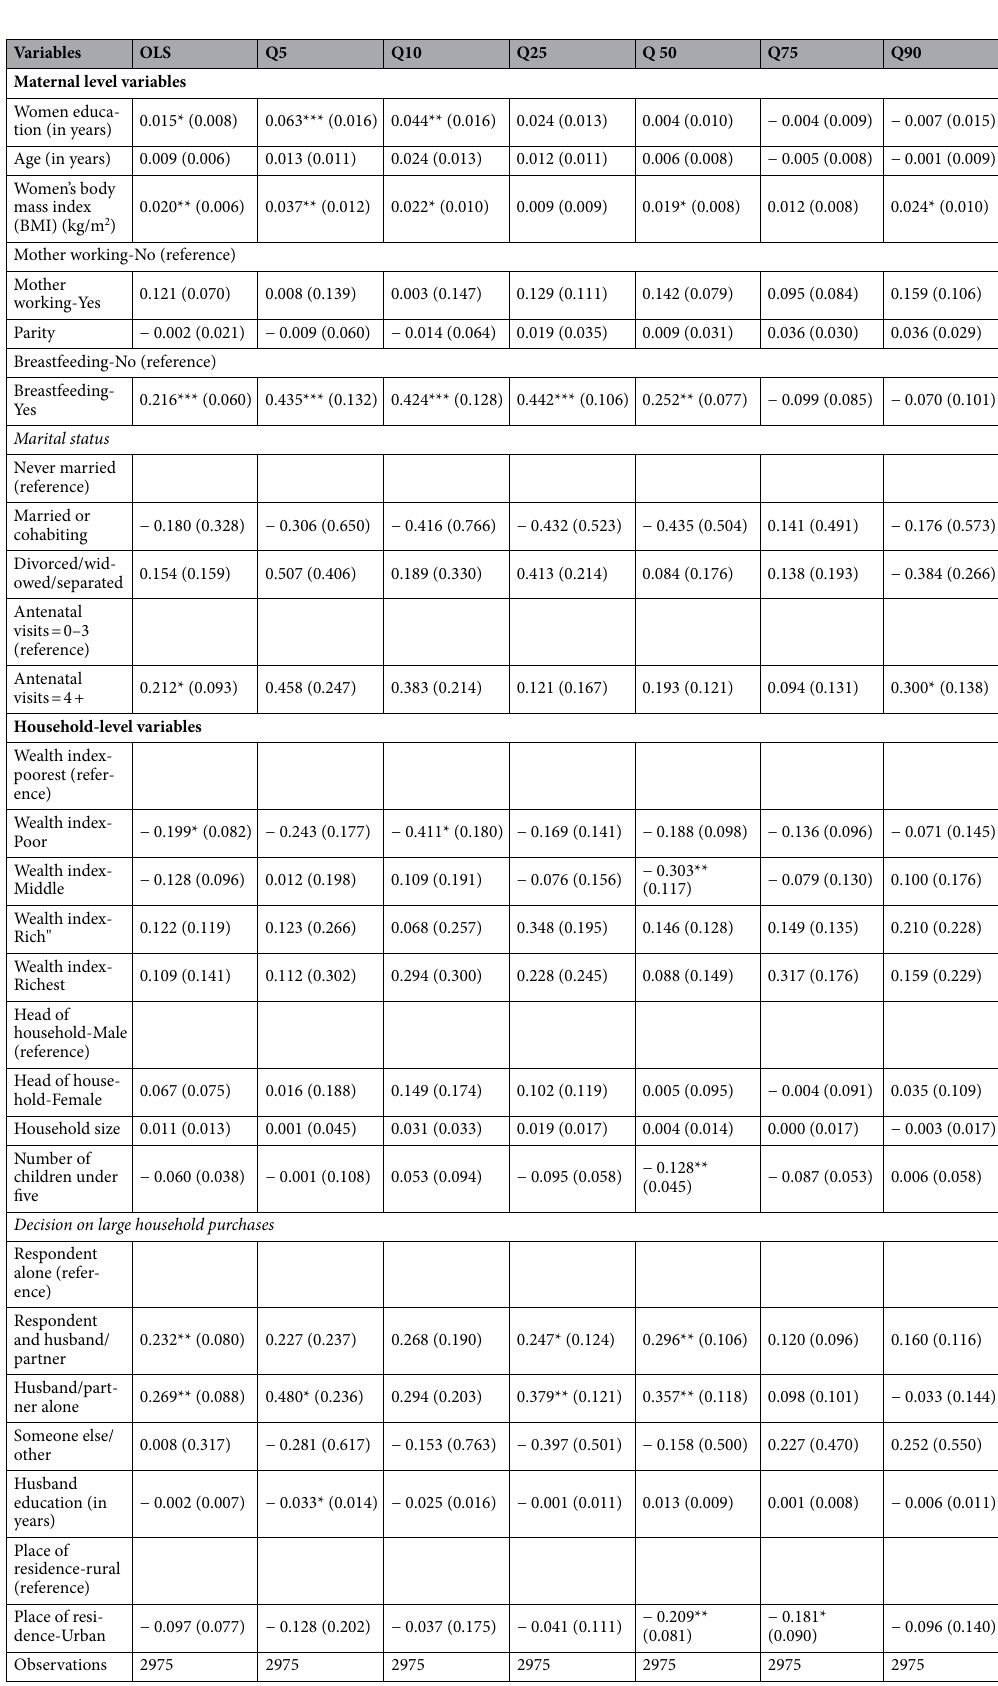
Table 2. Effects of socio-demographic factors on maternal Hb concentration in Ghana. Standard errors in parentheses. OLS ordinary least squares, Q quantile. *p < 0.05; **p < 0.01; ***p <